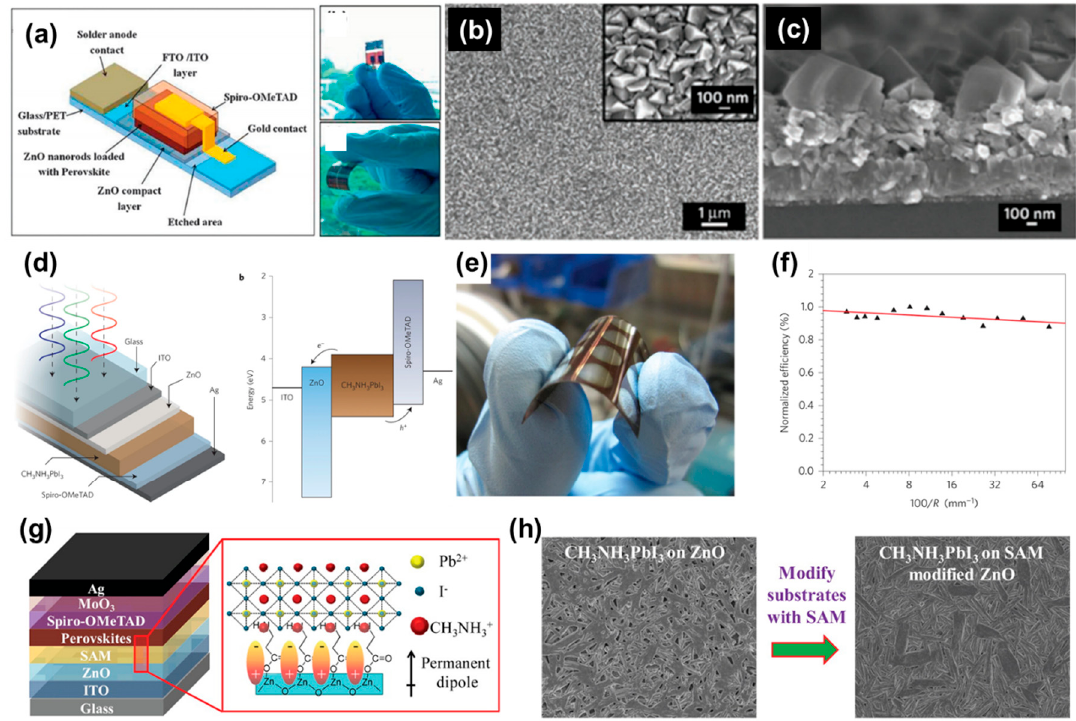
Figure 3. ( a ) Schematic illustration of the architecture for the perovskite devices. ( b ) Top down and ( c ) cross-sectional SEM images of the ZnO compact layer electrodeposited on FTO. Reprint with permission [44]; 2013, Royal Society of Chemistry. ( d ) Device structure and energy diagram of ITO/ZnO/CH 3 NH 3 PbI 3 /spiro-OMeTAD/Ag cells. ( e ) Photo of flexible device, ( f ) normalized PCE (measured on a flat device) after first bending the substrate. Reprint with permission [45]; 2014, Springer Nature. ( g ) Schematic illustration of perovskite solar cell employing self- assembled monolayer (SAM) device. ( h ) Top down images of perovskite on the FTO and modified ZnO. Reprint with permission [46]; 2015, American Chemical Society.